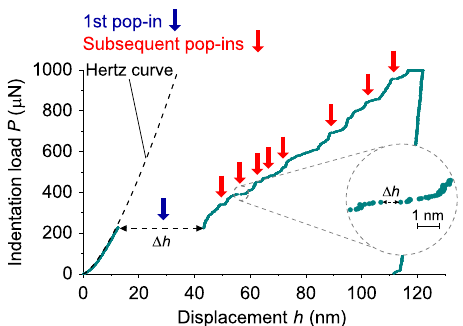
Fig. 1 Typical indentation load ( P ) vs. displacement ( h ) curve for the (100) surface of BCC Fe single crystal. The green line indicates the indentation load-displacement curve. The blue arrow and the red arrows indicate the fi rst pop-in and subsequent pop-in events, respectively, in the indentation. The curved broken line is drawn by Hertz's contact theory fi tted with the indentation load-displacement data before the fi rst